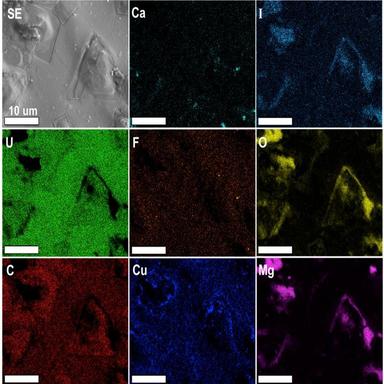
Image and elemental X-ray maps of a second area of the metal surface.